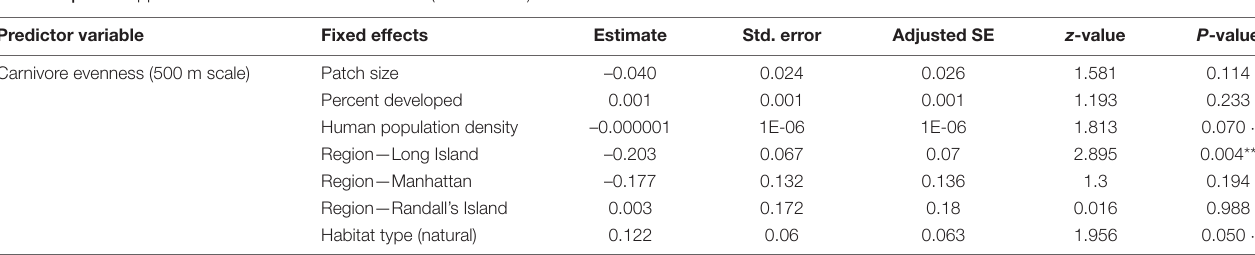
FIGURE 6 | Patterns among Carnivore evenness and region across the 31 study sites. Points and whiskers on the plot represent the mean and standard error. TABLE 7 | Best supported model for Carnivore evenness (500 m